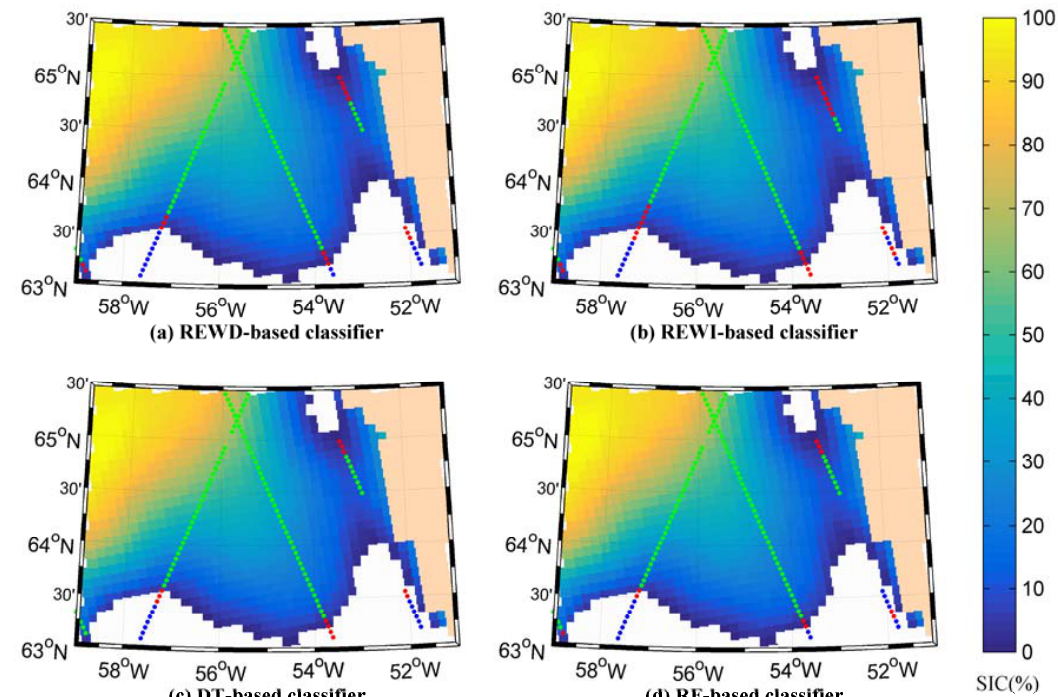
Figure 11. Examples of sea ice monitoring results validated against ASI SIC (sea ice concentration) maps from AMSR-2 data on the southwest side of Greenland on 14 March 2018 using four di ff erent methods: ( a ) the REWD thresholding approach, ( b ) the REWI thresholding approach, ( c ) the DT-based method in this study and ( d ) the RF-based method in this study. The land and sea water are represented as light brown and white, respectively. The sea ice concentration (SIC) is demonstrated by the color bar. The green and blue points represent the detected sea ice and sea water, respectively, while the red points represent the false detection.